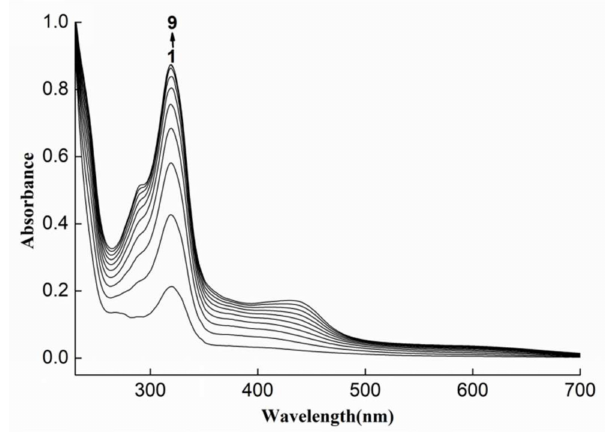
Figure 4. Absorption spectrum of pyrogallol in Tris-HCl buffer solution (pH = 8.2) after autoxidation for 0.5, 4.0, 8.0, 12.0, 16.0, 20.0, 24.0, 28.0 and 32.0 min (1–9).